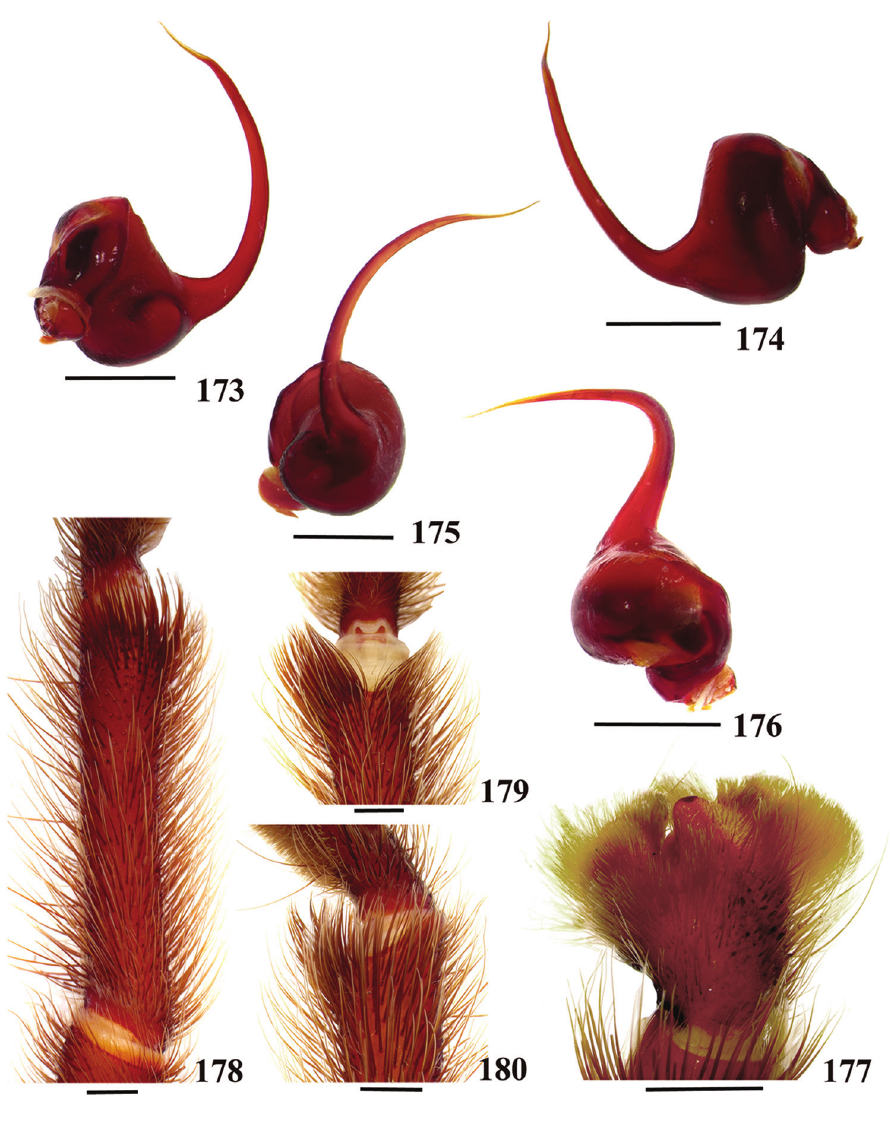
Figures 173–180. Avicularia hirschii Bullmer, Thierer-Lutz & Schmidt, 2006, male holotype (SMF 57125). 173–176 right palpal bulb (mirrored) 173 prolateral 174 retrolateral 175 frontal 176 dorsal 177 right cymbium, dorsal (mirrored) 178–180 left tibia I 178 prolateral 179 ventral 180 retrolateral. Scale bars = 1